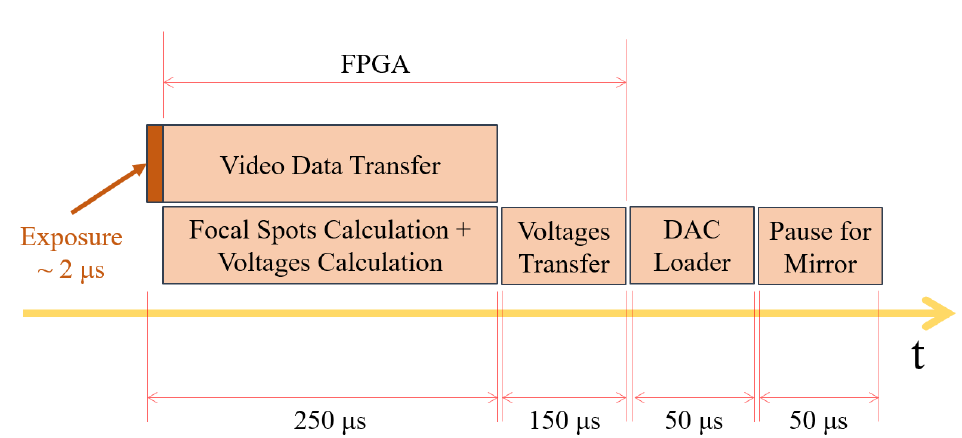
Figure 4. FPGA timing diagram. The total time of one closed cycle is 500 microseconds, which cor- responds to an operating frequency of 2000 Hz.